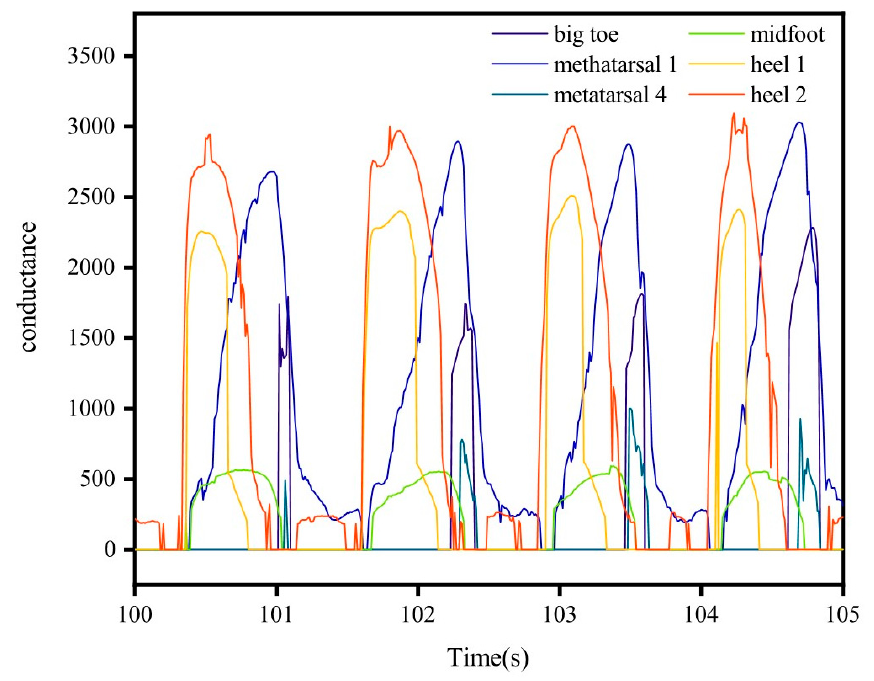
Figure 7. Gait cycles reflected by the signals of the designed insole.